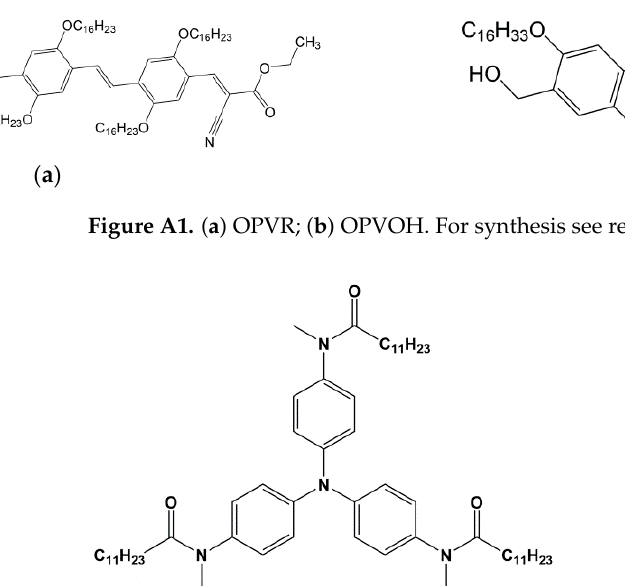
Figure A2. TATA: tri-aryl tri-amine. For synthesis see reference [27].